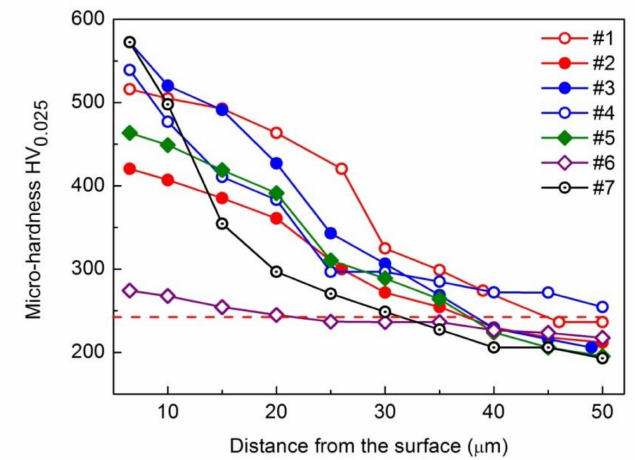
Figure 6. Micro-hardness (load of 25 g) profiles vs. distance from the exposed surface of 316 L samples treated in different conditions.